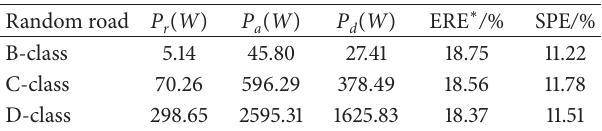
Table 5: Self-powered